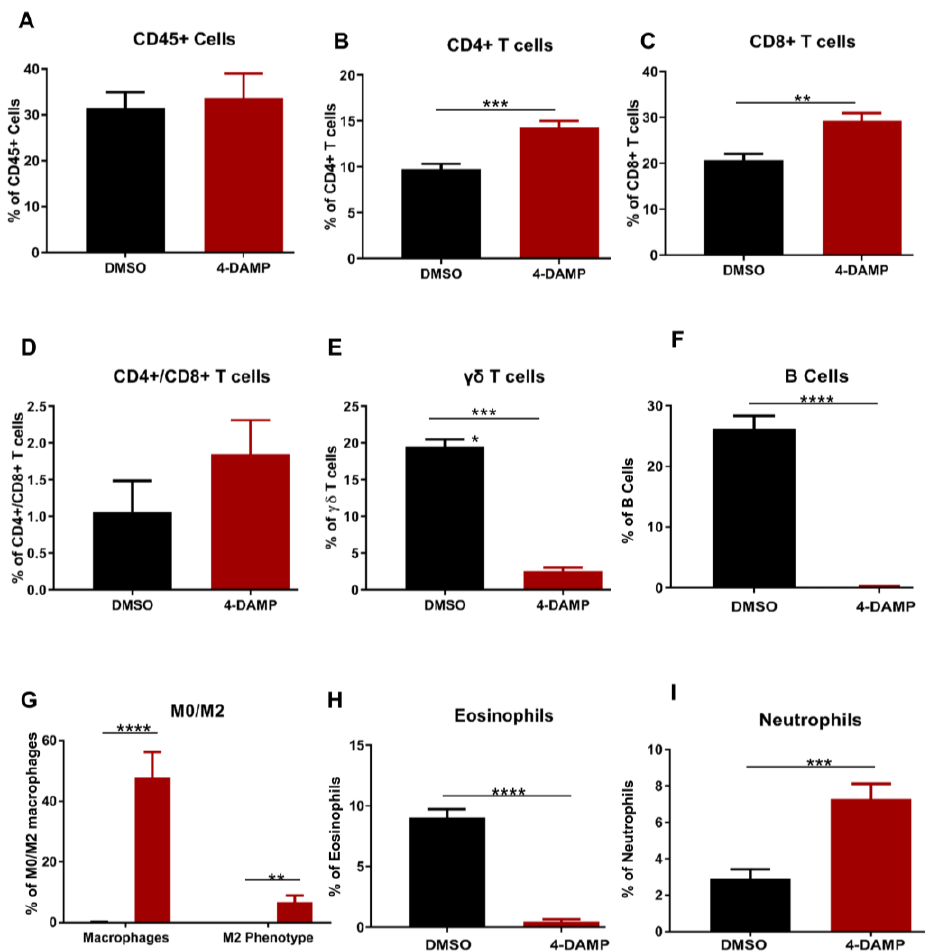
Figure 7. Flow cytometric analysis of CD45+ cells and T lymphocytes. Proportion of the CD45+ cells ( A ), CD4+ T cells ( B ), CD8+ T cells ( C ), CD4+/CD8+ T cells ratio ( D ), γδ T cells ( E ), B cells ( F ), eosinophils ( G ), macrophages ( H ) and neutrophils ( I ) in tumors from DMSO-treated and 4-DAMP-treated groups. Data presented as mean ± SEM, DMSO-treated (n = 4), 4-DAMP-treated (n = 7) mice per group. Student’s t- test, ** p < 0.01, *** p < 0.001, **** p < 0.0001.